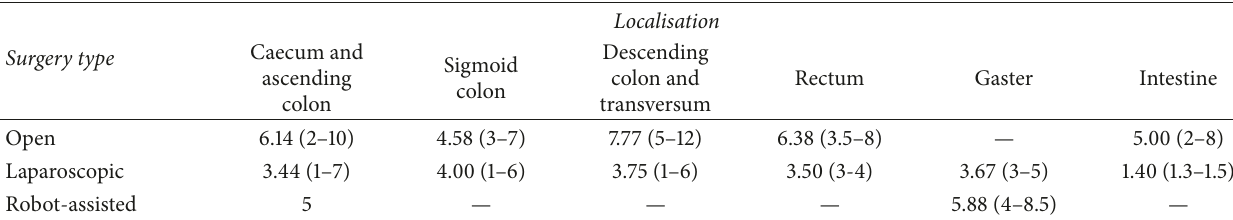
Table 3: Tumour long diameter (cm) for patients involved in the study. The mean values are presented, along with the minimum and the maximum values (where